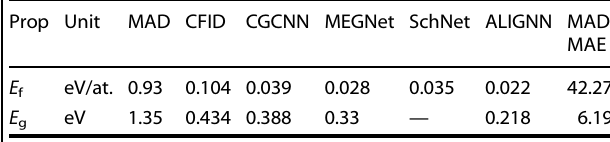
Table 2. Test set performance on the Materials Project dataset. Prop Unit